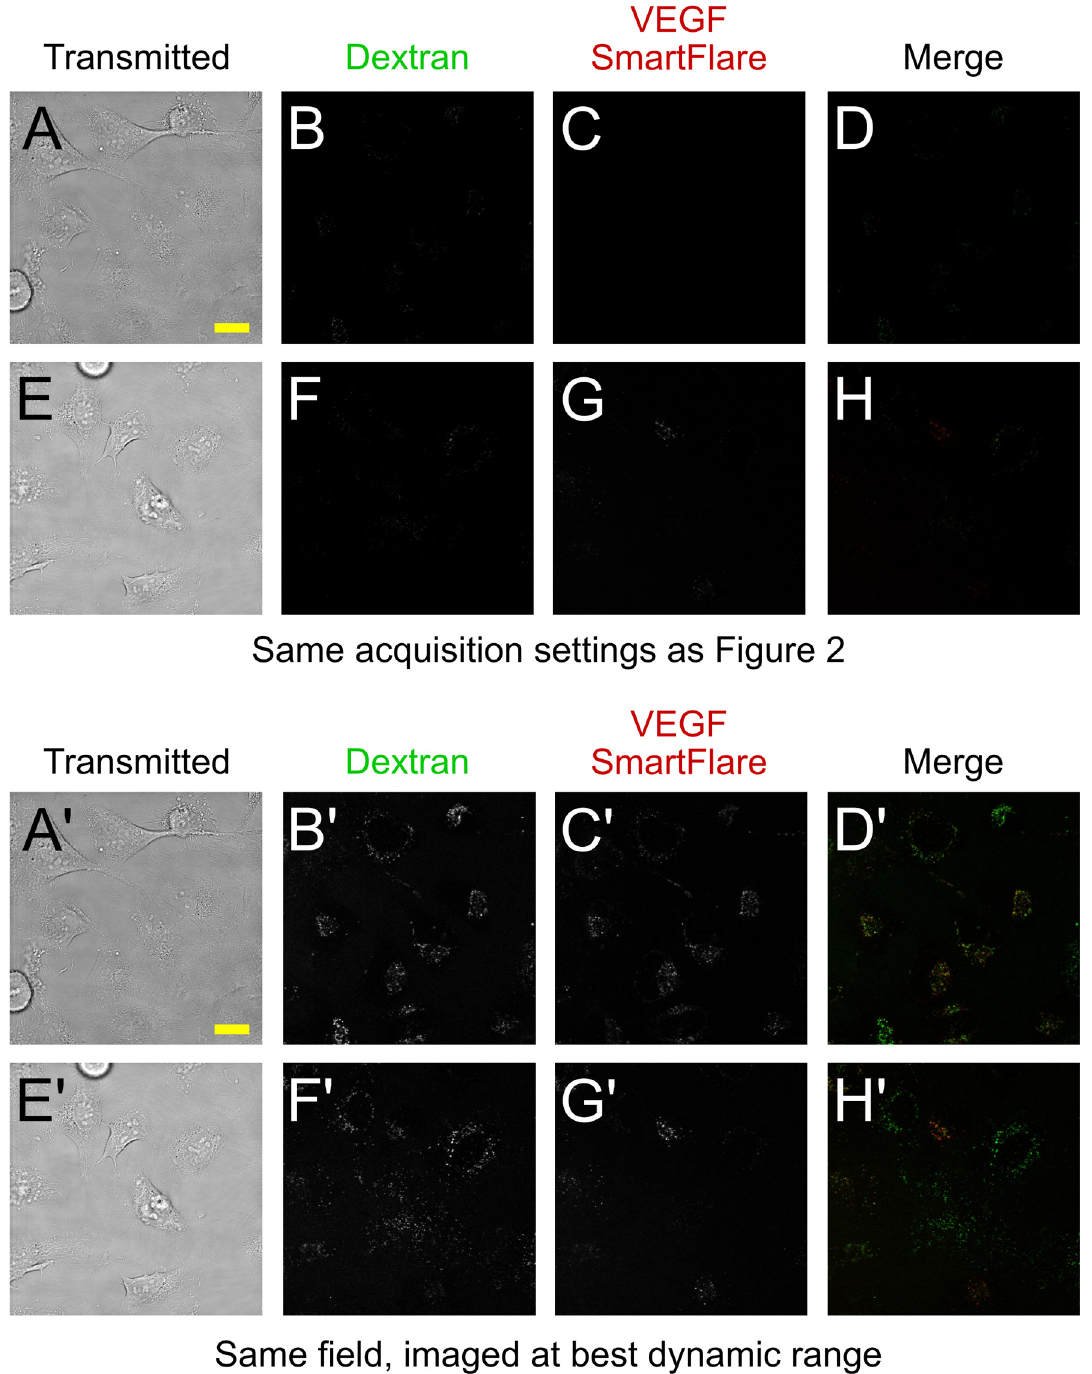
Supplementary Figure S1. SmartFlare uptake at 2 hours : HeLa cells were exposed to Uptake Control (A – D) or VEGF (E – H) SmartFlares for 2 hours, then washed and imaged with confocal laser-scanning microscopy in fl uorescence (B,C,F,G) or transmitted (A,E) channels. An overlay of the SmartFlares (pseudo-coloured red) and Dextran (pseudo-coloured green) is shown in D & H. The top panels (A – H) show the same imaging parameters as were used for 18 hour experiments. The bottom panels (A ′– H ′ ) shows the identical fi eld imaged with optimal dynamic range for visualisation. All frames are shown at identical magni fi cation, scale bar represents 20 μ